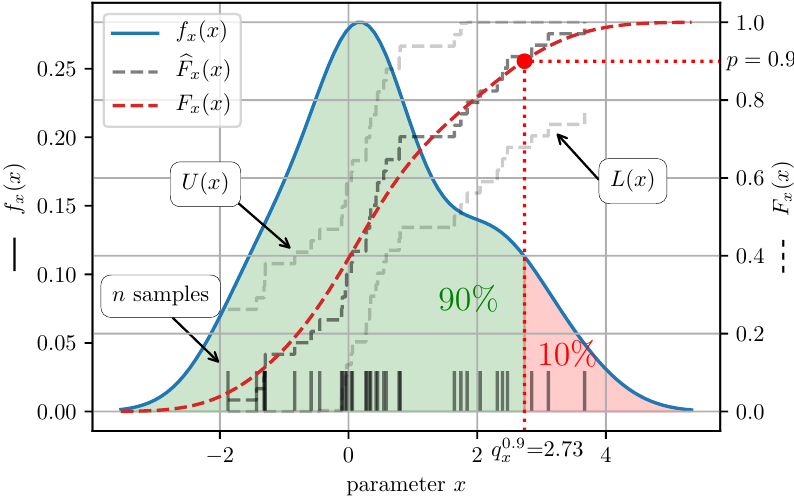
Figure 2. Explanation of the (E)CDF based on n = 34 random samples (black lines): empiric cumulative F x ( x ) ; probability density function f x ( x ) fitted by kernel density estimation; distribution function cumulative distribution function F x ( x ) from f x ( x ) (cf. (2)); lower L ( x ) and upper U ( x ) confidence (cid:98) bound derived from the Dvoretzky–Kiefer–Wolfowitz inequality (cf.